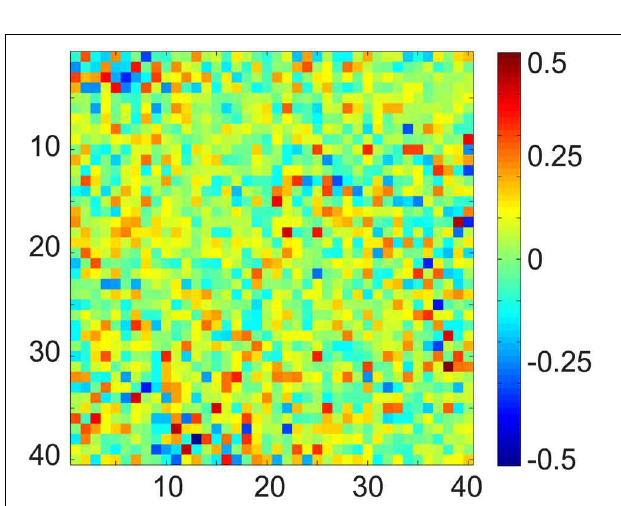
FIGURE 6 | Synthesis of contaminated data. We use the BCG data from channel B (blue) as the prior BCG data denoted as ˜ X b _ prior after alignment. The EEG data from channel A or B (blue) can be used as